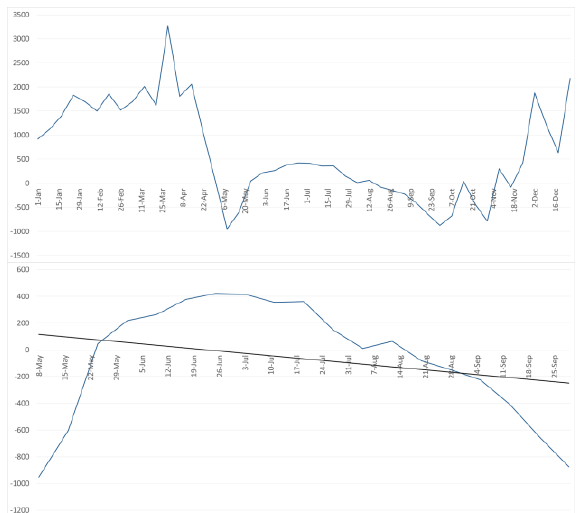
Figure 2. Sample of the annual NDWI graph (upper image) and the part of the graph that is used to allocate framing dates of the growing seasons; index values are scaled by 10000